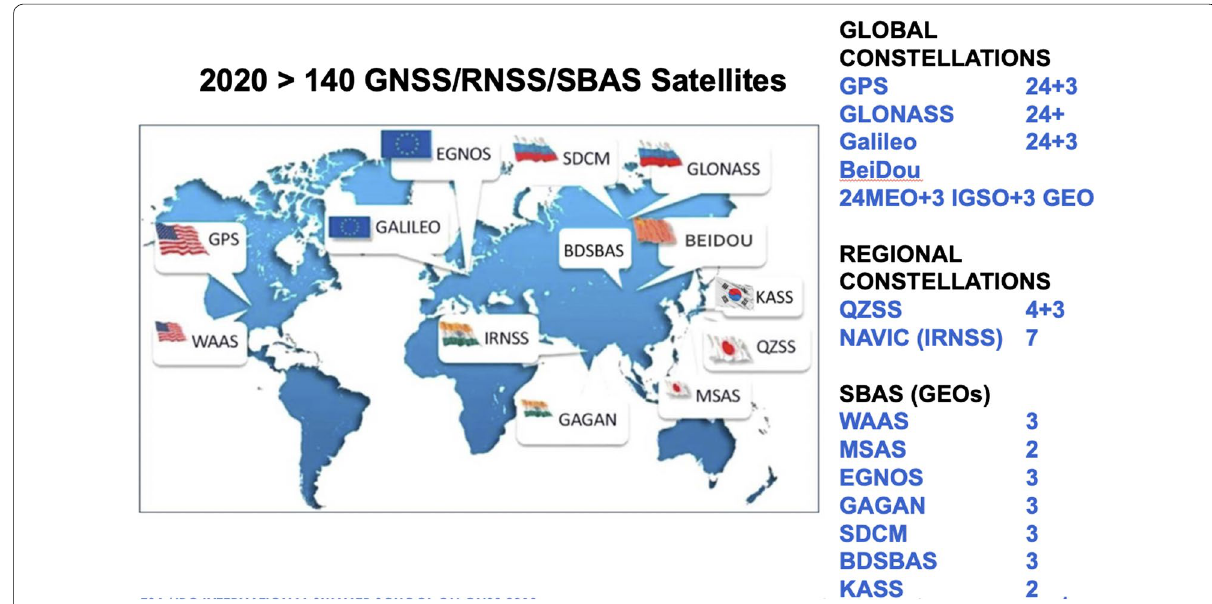
Fig. 2 GNSS: a system of systems. (The South Korean System KPS is not considered since developments did not start